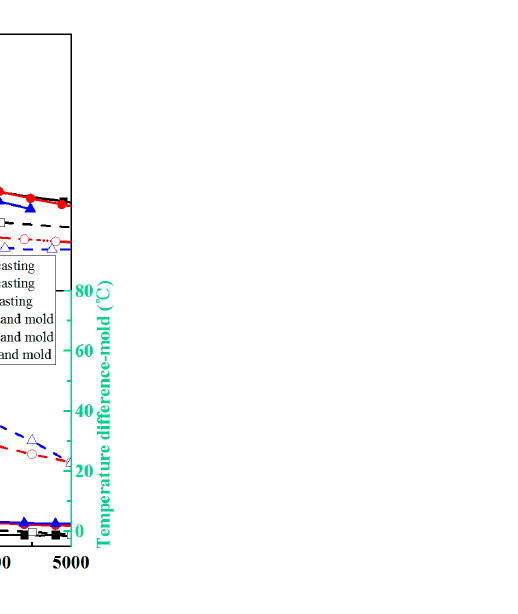
Figure 15. Comparison of temperature and temperature gradient of three groups of sand mold and casting.